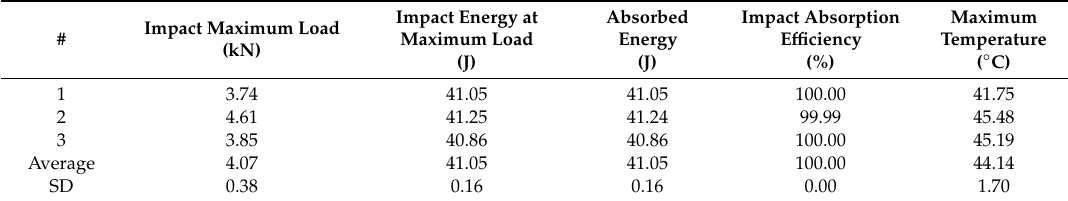
Figure 5. Impact test results of Type 3: ( a ) changes in load and energy with time, ( b ) impact load and displacement curve, ( c ) changes in temperature with time, ( d ) impact test of specimen Type 3, and ( e ) IR image of impact test (Type 3). Table 7. Impact test results of Type